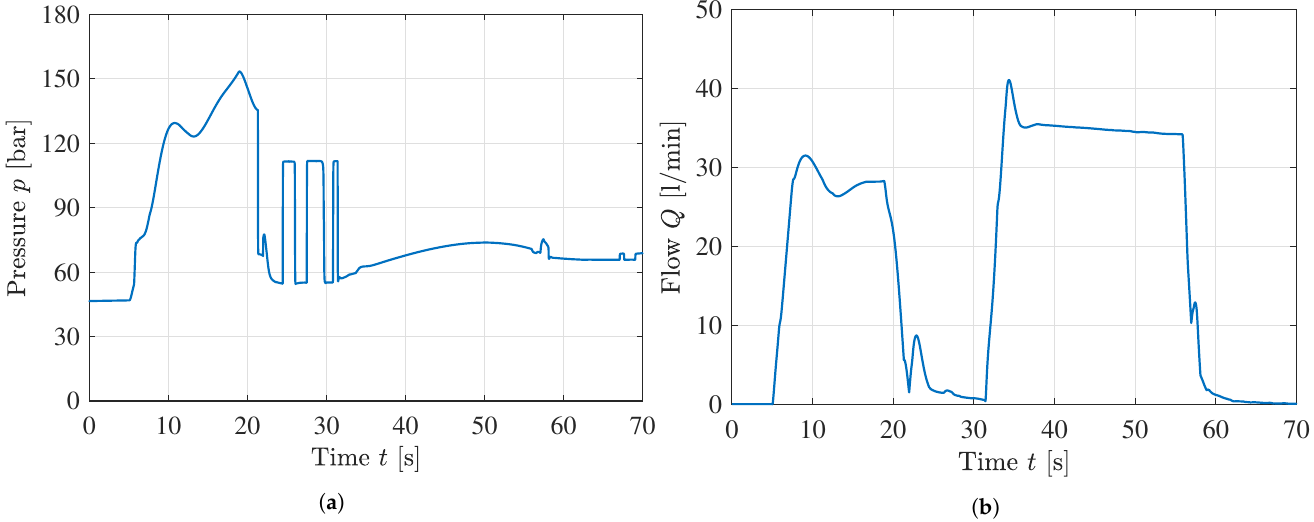
Figure 29. Pump pressure and flow during motion with valve-controlled actuators. ( a ) Pump pressure; ( b ) Pump flow. A plot of the power and consumed energy is shown in Figure 30. During motion 46 kJ was delivered to the cylinders while 505 kJ was consumed from the grid. This yields an overall efficiency of less than